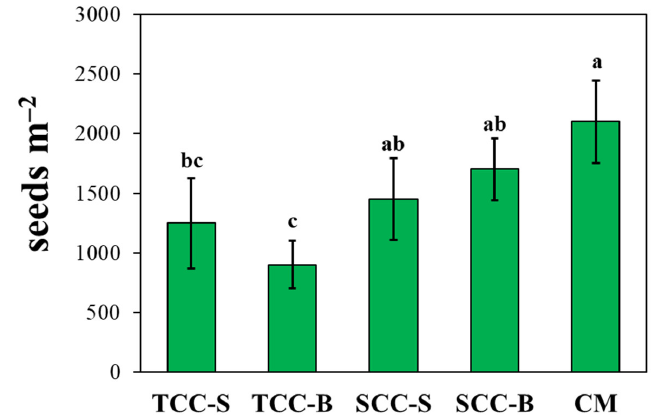
Figure 2. Cumulative e ff ect on the soil weed seed bank after 5 years of di ff erent cover cropping systems. Bars are standard deviation ( n = 4). Di ff erent letters indicate statistical significance at p ≤ 0.05